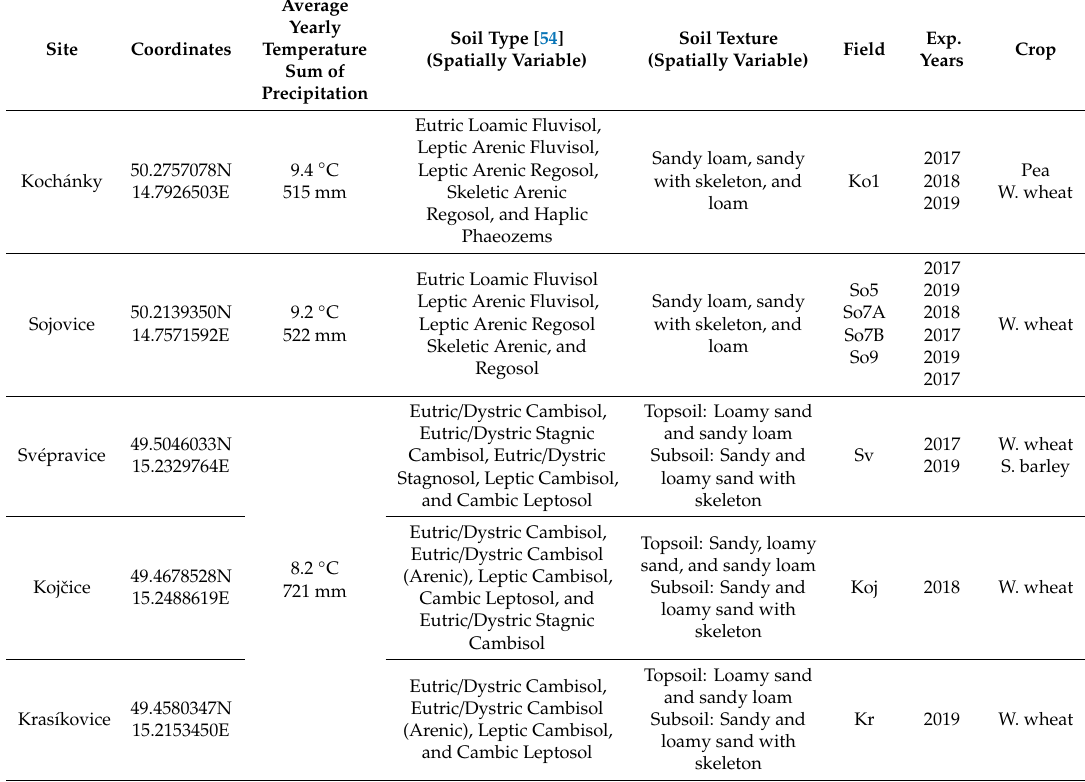
Table A1. Overview of the conditions of the experimental sites (Czech